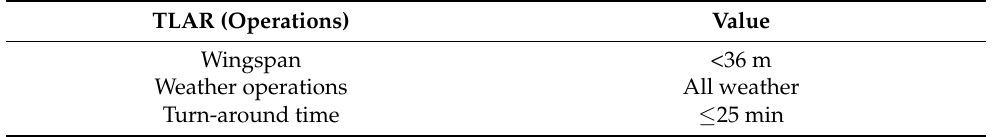
Table 3. Top-level aircraft requirements with regard to operational aspects. TLAR (Operations) Value Wingspan <36 m Weather operations All weather Turn-around time ≤ 25